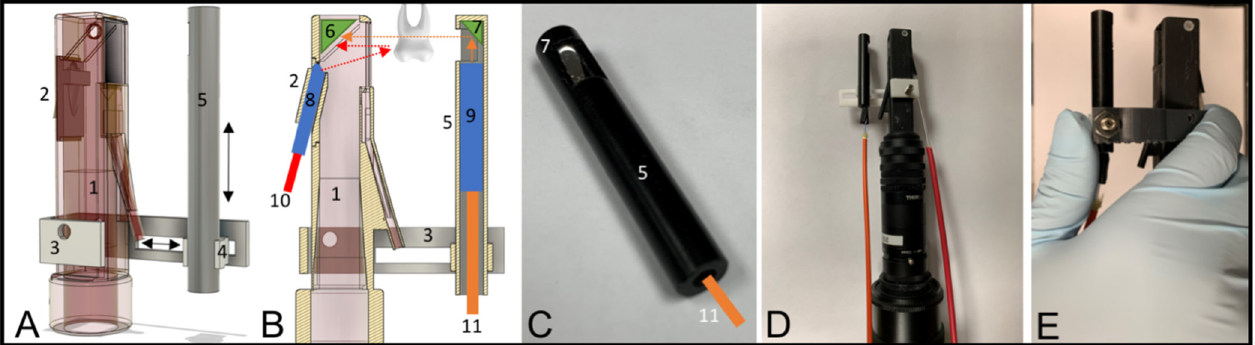
Figure 2. ( A ) 3D rendering and ( B ) cross-section of the dual SWIR proximal probe is shown. Major parts include: (1) probe main body, (2) reflectance backpiece, (3) sliding frame, (4) Delrin rod holder, (5) Delrin tube, (6), right-angled rectangular aluminum reflector, (7) right-angle cylindrical aluminum reflector, (8) Teflon tube for reflectance light source, (9) Teflon tube for proximal transillumination light source, (10) optical fiber delivering 1450 nm light for reflectance, (11) optical fiber delivering 1300 nm light for proximal transillumination. Proximal transillumination light propagation is shown in orange dashed arrows. Reflectance light propagation is shown with red dashed arrows. ( C ) Proximal transillumination light source (11) is encased in a Teflon tube placed inside a Delrin tube (5).